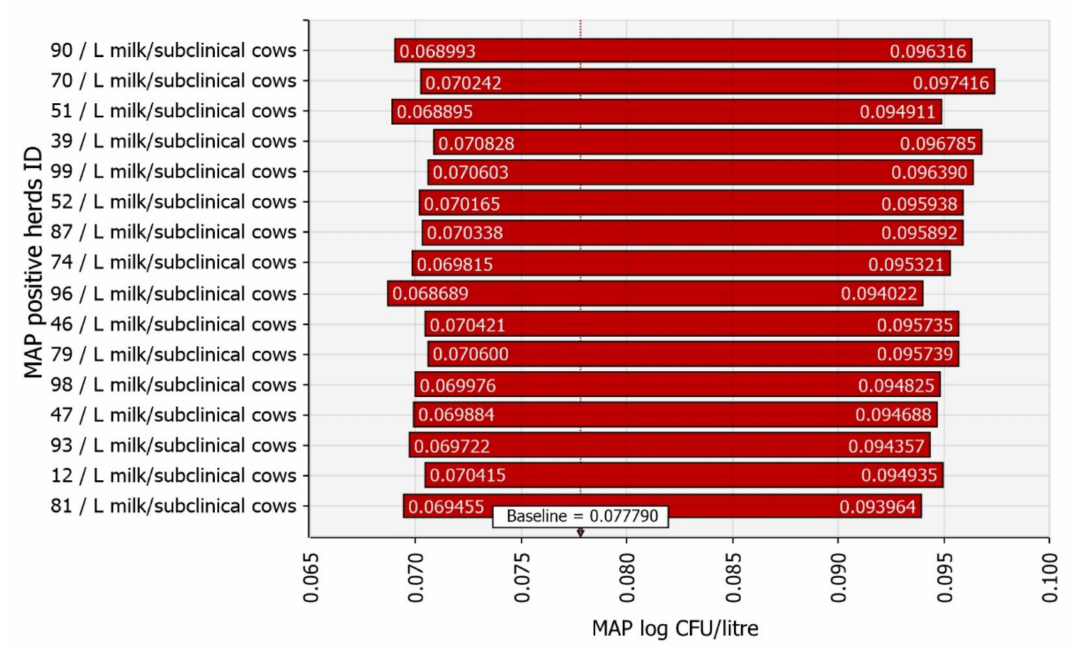
Figure 6. Correlation between Mycobacterium avium subsp. paratuberculosis (MAP) contamination of raw bulk tank milk and the number of dairy cows per MAP positive herd.